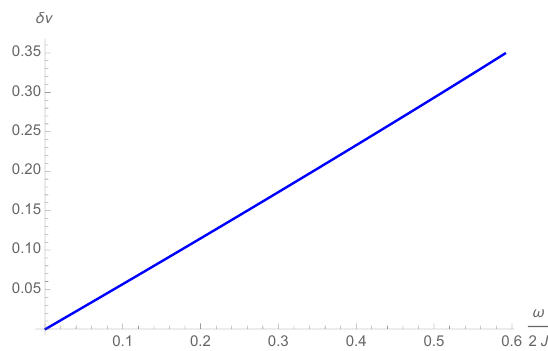
Figure 4 . Plot of the absolute difference between the allowed values of ν from two different methods, where we have defined δν = ν approx − ν exact where ν approx refers to the values of ν obtained by solving (C.20). We see that the difference grows with ω . 2 J ω 2 J